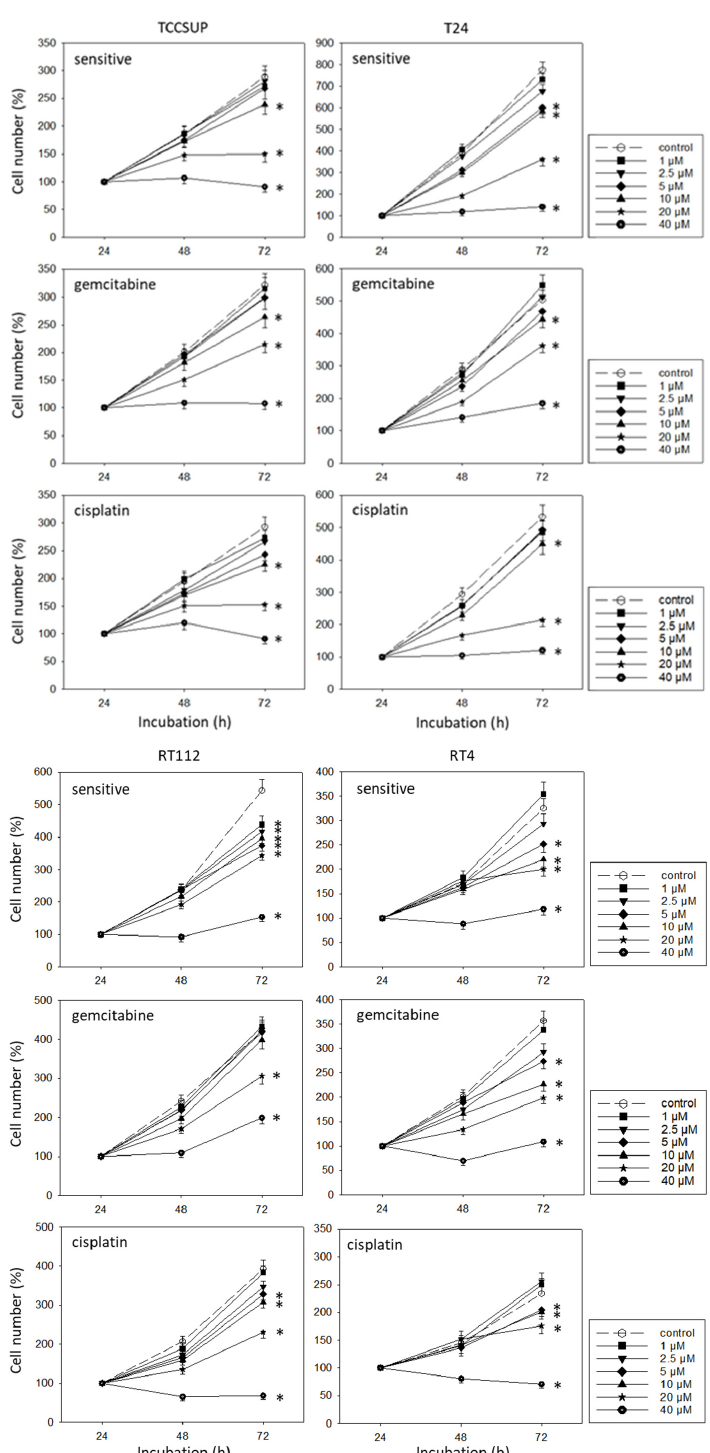
Figure 2. Influence of SFN (1–40 µM) on the growth of sensitive and cisplatin- and gemcitabine- resistant TCCSUP, T24, RT112, and RT4 bladder cancer cell lines. The cell number was evaluated after 24, 48, and 72 h using the MTT assay. After subtracting the background absorbance and offsetting with a standard curve, the results are expressed as the mean cell number. The mean cell number after 24 h was set to 100%. Error bars indicate the standard deviation (SD), n = 6. * indicates a significant difference compared to the non-treated control.